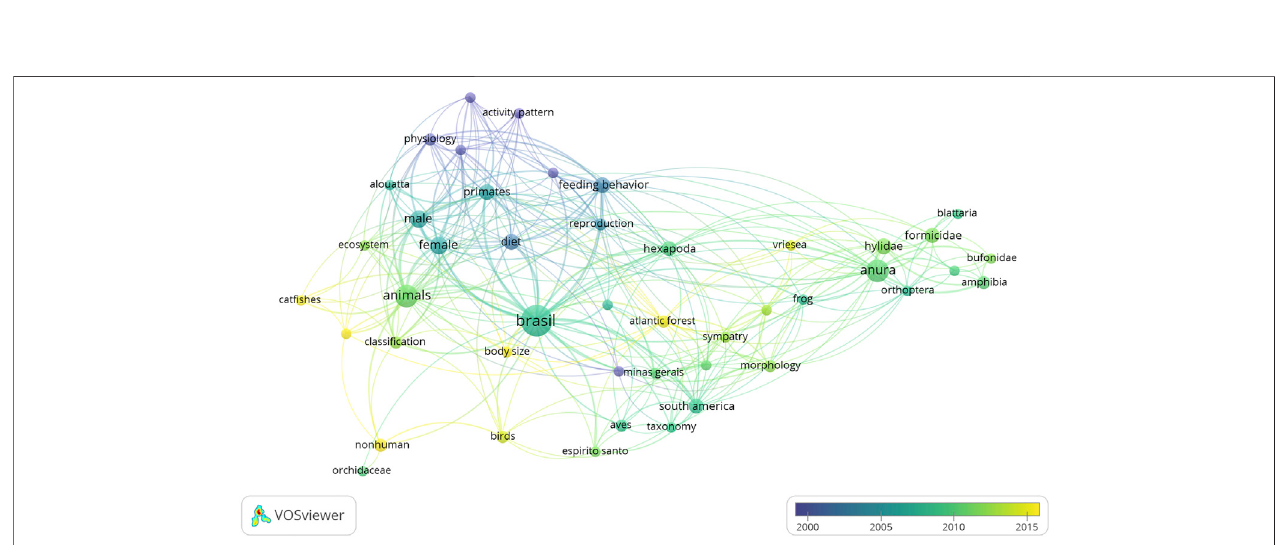
FIGURE 3 | Co-occurrence between the indexed terms of the analyzed institutional production and their incidence every fi ve years (1993 – 2019).